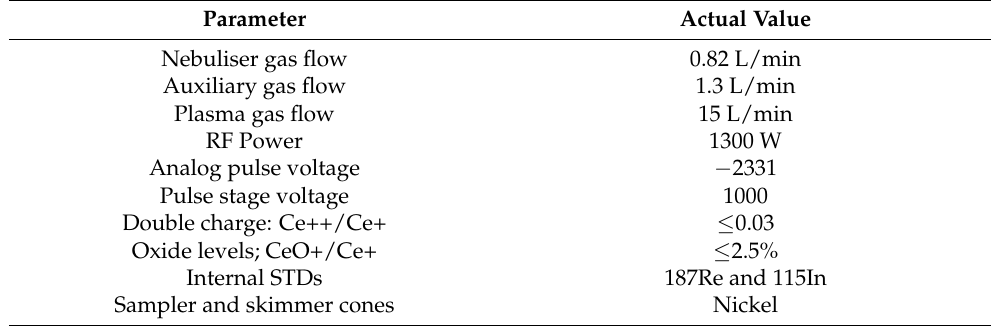
Table 1. NexION-ICP-MS operating and measurement conditions for the determination of